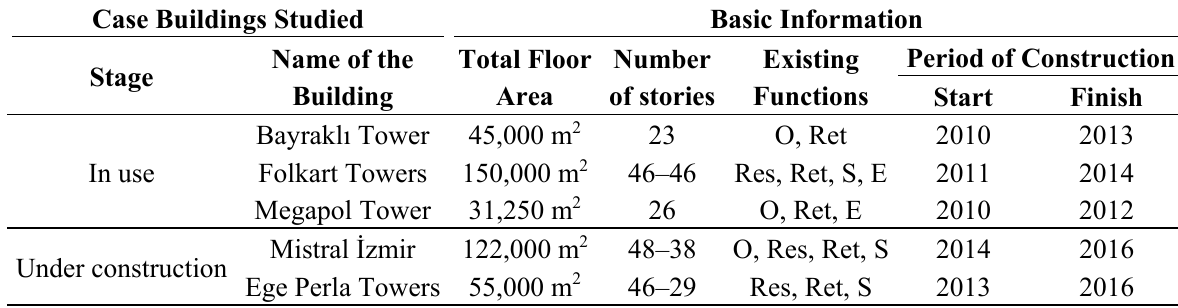
Table 2. Basic Information about the case buildings studied (O: Office; Ret: Retail; Res: Residence; E: Exhibition; S: